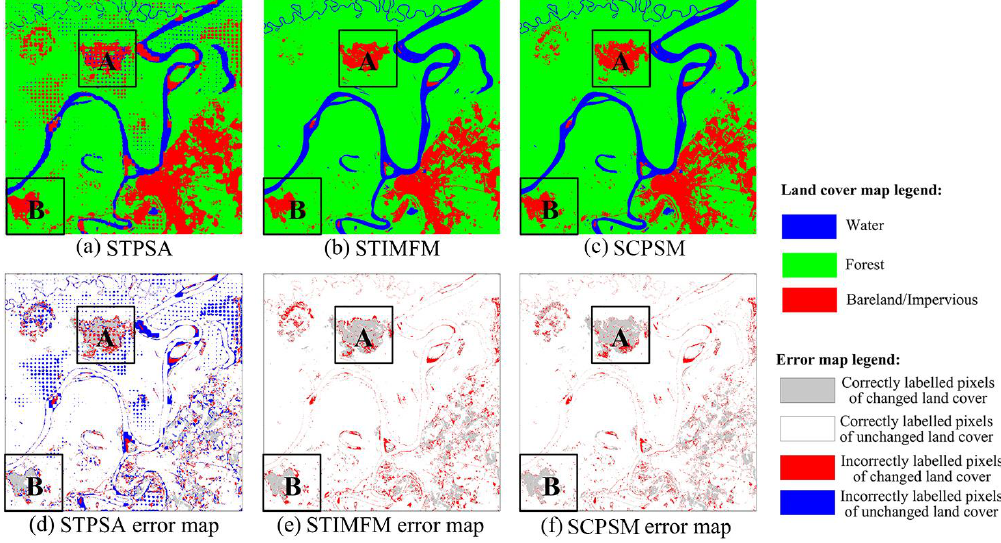
Figure 8. The result of land cover maps predicted from di ff erent methods and the corresponding error maps in the experiment for the forest fire experiment. ( a ) STPSA; ( b ) STIMFM; ( c ) SCPSM; ( d ) STPSA error map; ( e ) STIMFM error map; ( f ) SCPSM error map.